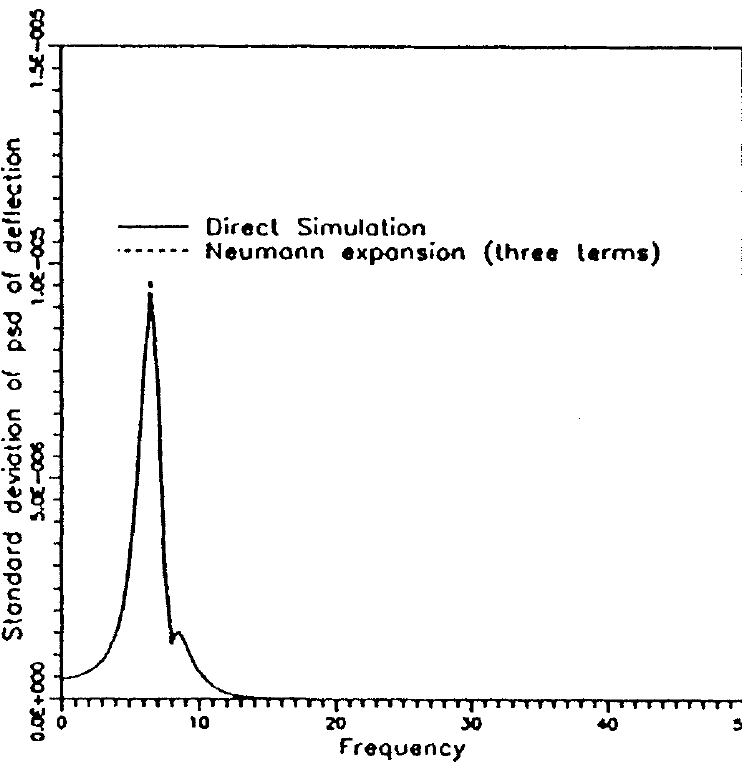
Fig. 4. Standard deviation of the psd of deflection at node 46 of the plate (c.o.v. =